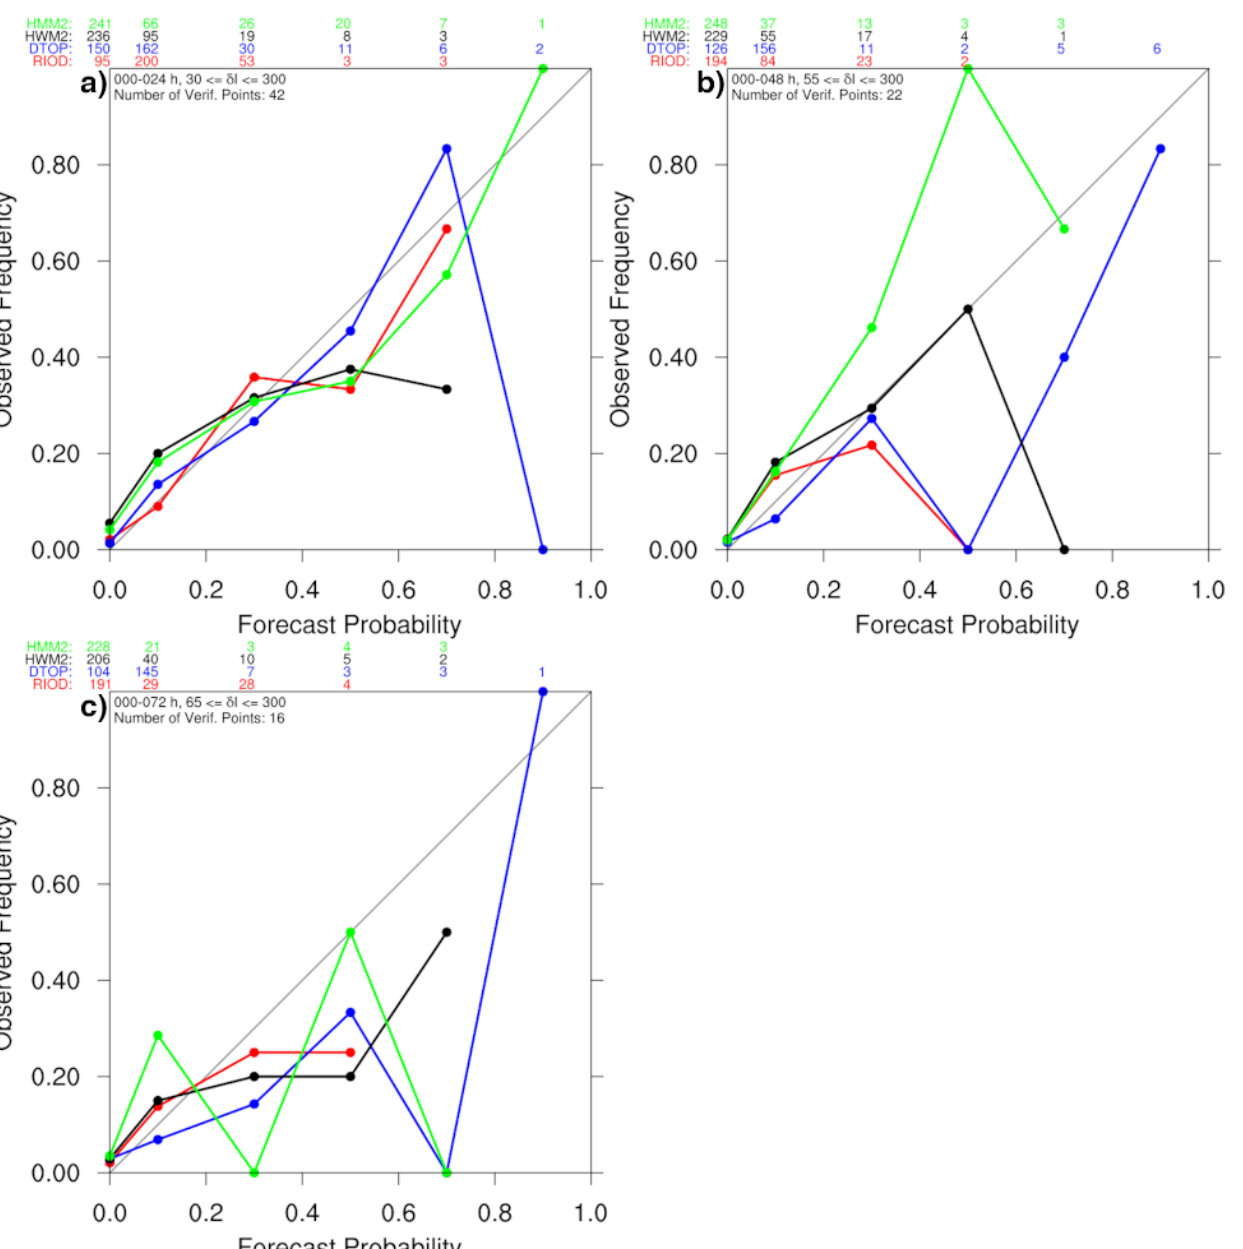
Figure 4. Reliability diagrams for ( a ) 0–24 h TC maximum wind speed change >= 30 knots, ( b ) 0–48 h TC maximum wind speed change >= 55 kts, and ( c ) 0–72 h TC maximum wind speed change >= 65 knots for interpolated HWRF ensemble (HWM2; black), interpolated HMON ensemble (HMM2; green), SHIPS Rapid Intensification Index (RIOD; red), and DTOPS (DTOP; blue) models during 2017–2019. The number of cases within each category is given along the top of each